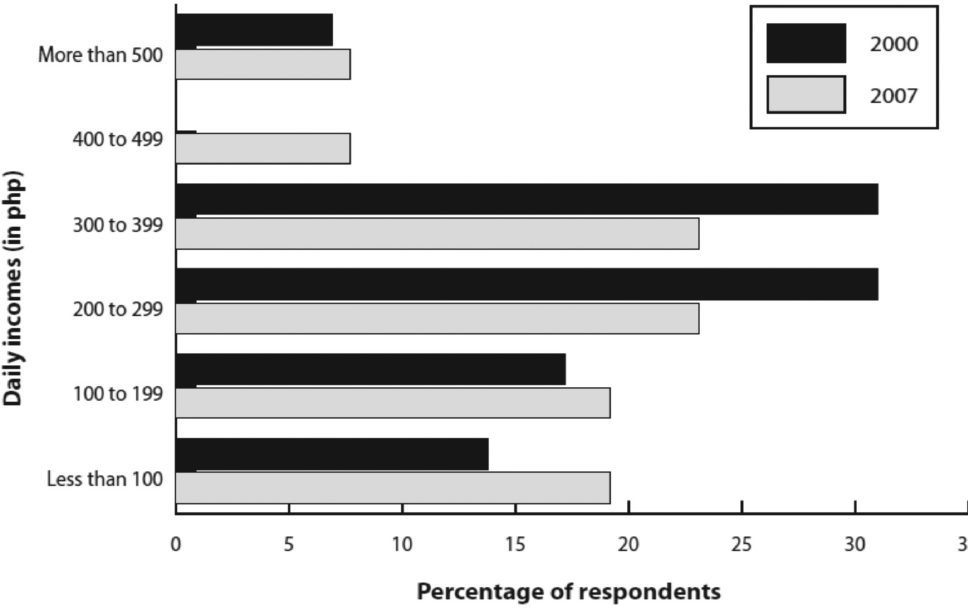
From marginality to further marginalization: Experiences from the victims of the July 2000